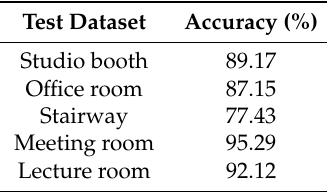
Figure 11. Confusion matrices showing the performances of models trained separately in a ( a ) Studio booth; ( b ) O ffi ce room; ( c ) Stairway; ( d ) Meeting room; and ( e ) Lecture room. Accuracy of the proposed method when trained and tested in each public dataset room